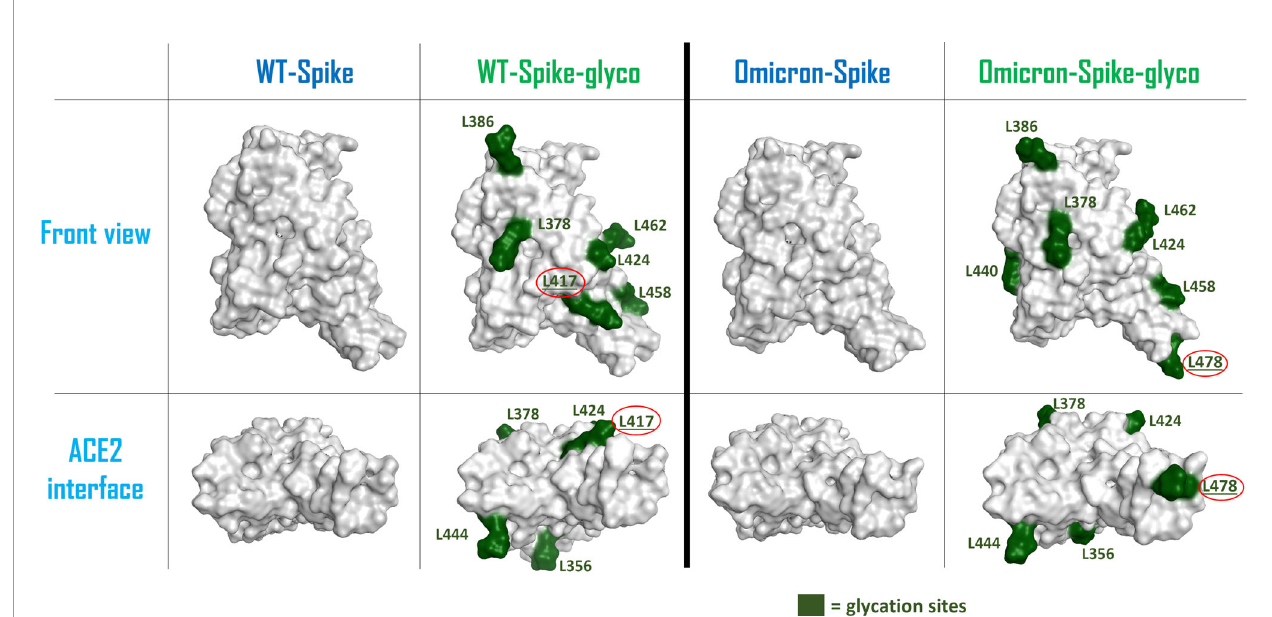
FIGURE 3 | Schematic representation of the surfaces of the possible forms of Spike-RBD considered in this computational study. From the left, the systems considered are: wild-type (WT) Spike-RBD, the lysine-glycated form of wild-type (WT) Spike-RBD, the Omicron variant Spike-RBD and the glycated form of Omicron variant Spike-RBD. For the glycated systems, the surface of lysine amino acids has been colored in dark green and has also been labeled. The lysine which are located on the contact interface with ACE2 (Lys417 for the WT-Spike-RBD-glyco and Lys478 for the Omicron-Spike-RBD-glyco) have their label underlined and circled in red. The top fi gures represent a lateral view of the Spike-RBDs considered, while the bottom fi gures highlight the protein surface facing the ACE2 interaction interface for each situation examined. RBD, receptor-binding